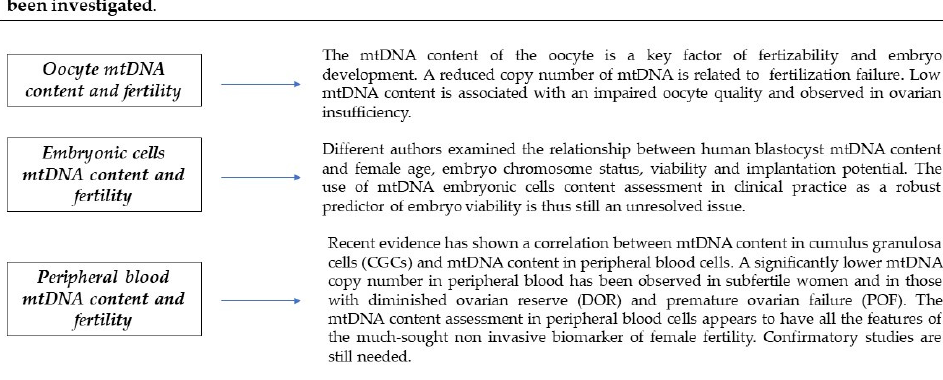
Figure 3. Quantitative mtDNA alterations and female fertility.